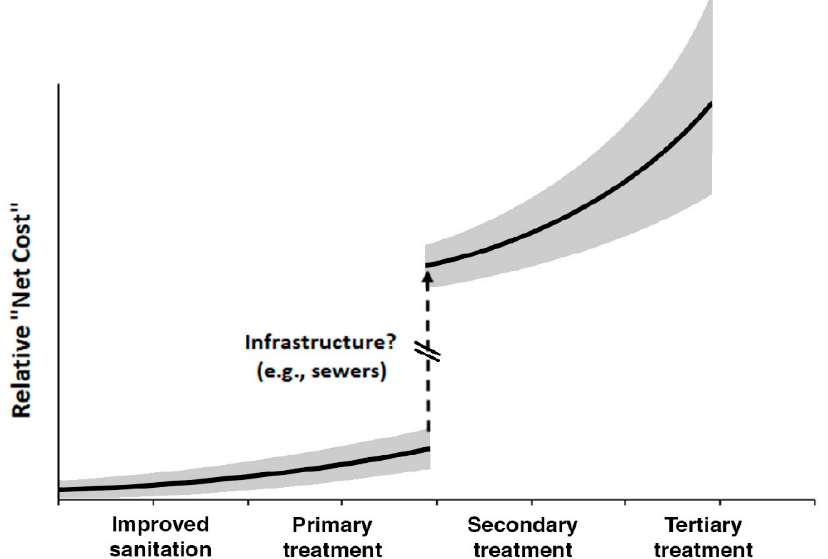
. Figure 3. Relative incremental “net cost” increases as a function of AR mitigation interventions (see .